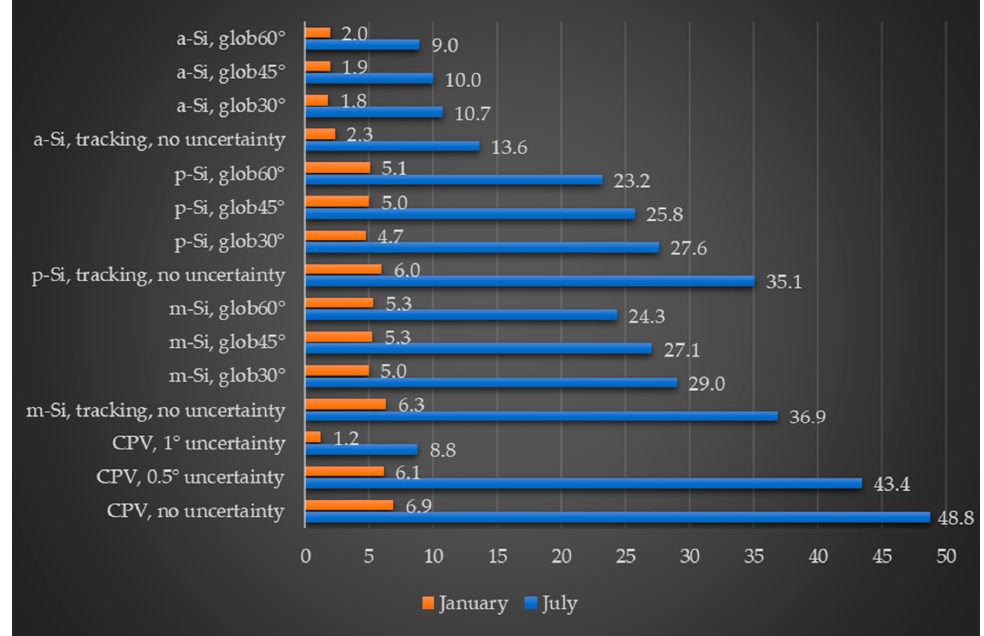
Figure 12. Calculated yields for January and July 2018 for 4 different technologies: CPV, a-Si, m-Si, and p-Si. The results are shown for sun tracking systems (CPV, a-Si track, m-Si track, p-Si track) and for fixed PV modules with inclinations of 30 degrees (a-Si 30°, m-Si 30°, and p-Si 30°) of 45 degrees (a-Si 45°, m-Si 45°, and p-Si 45°) and 60 degrees (a-Si 60°, m-Si 60°, and p-Si 60°). In addition, the yields of a CPV module mounted on a solar tracker with a 0.5° tracking uncertainty (CPV 0.5° uncert) and with a 1° tracking inaccuracy (CPV 1° uncert.) are shown.